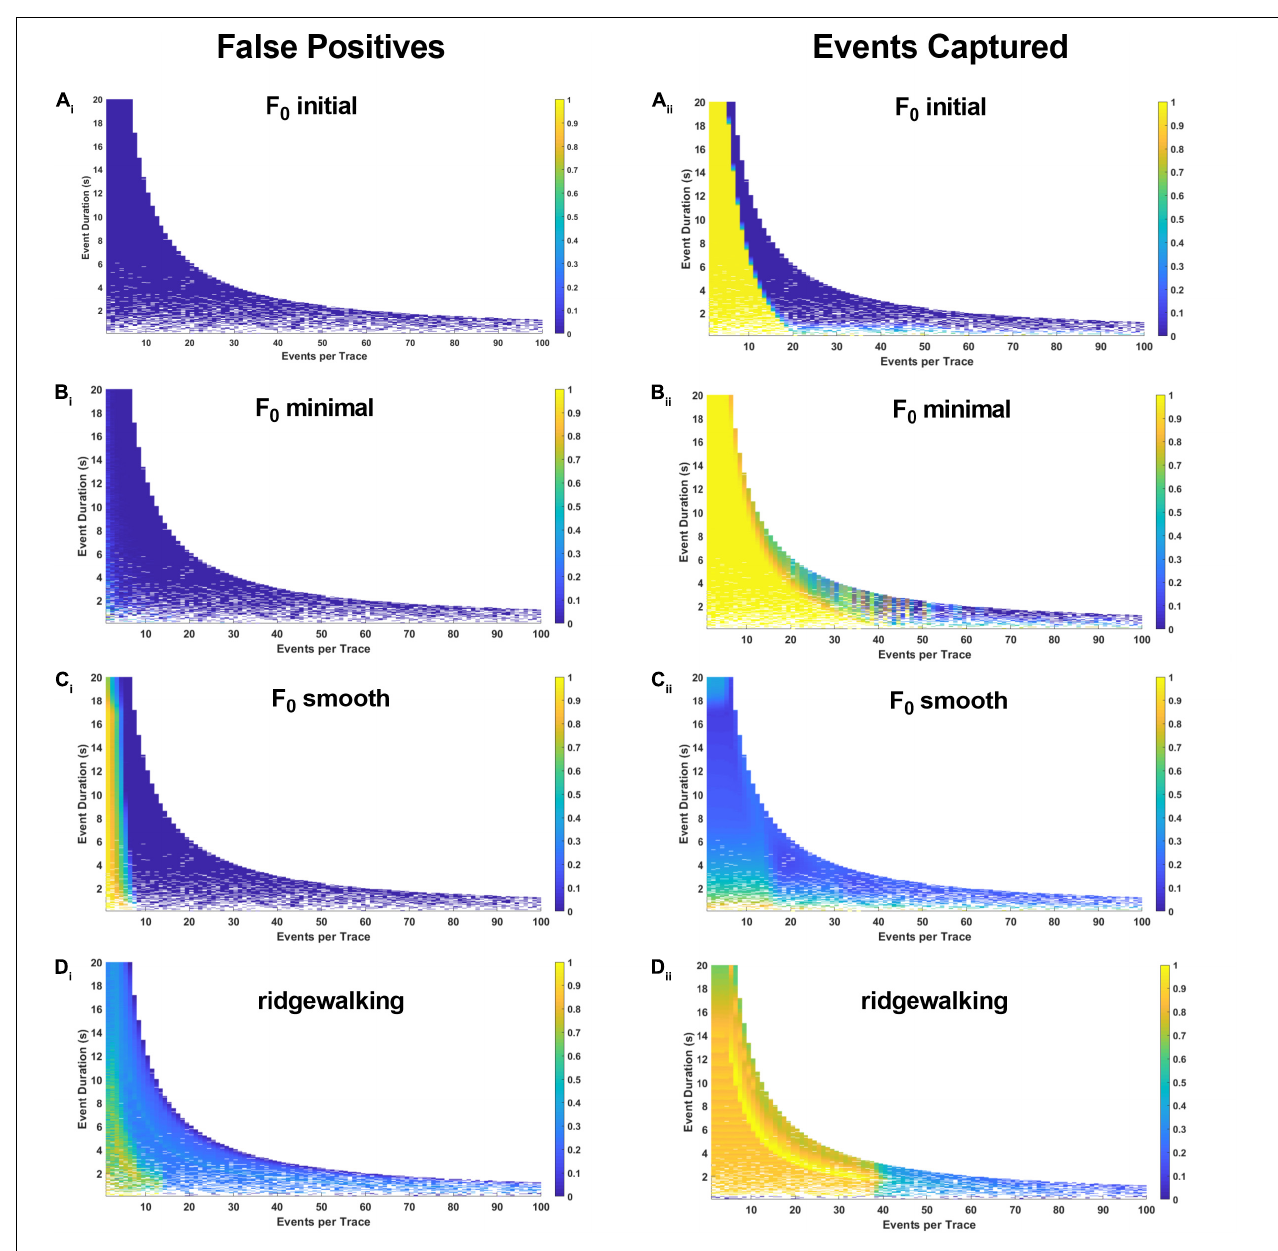
FIGURE 4 | Synthetic data for pseudoneuronal events with linear decay. The left-hand plots represent “false positives” or the fraction of rasters existing outside of known event bounds, and the right-hand plots represent the “events captured” or the fraction of total event bounds that are covered by the rasters. (A i , ii ) Results for F 0 initial thresholded at 2.5 baseline standard deviations. (B i , ii ) Results for F 0 minimal thresholded at 2.5 baseline standard deviations. (C i , ii ) Results for F 0 smooth thresholded at 2.5 baseline standard deviations. (D i , ii ) Results for wavelet ridgewalking